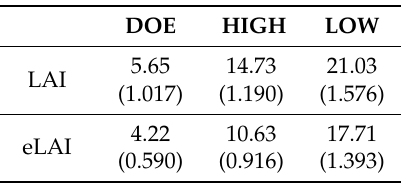
Table 6. The overall average of MAPE (%) with algorithm modification (numbers in parentheses are upper bounds of a 95% confidence